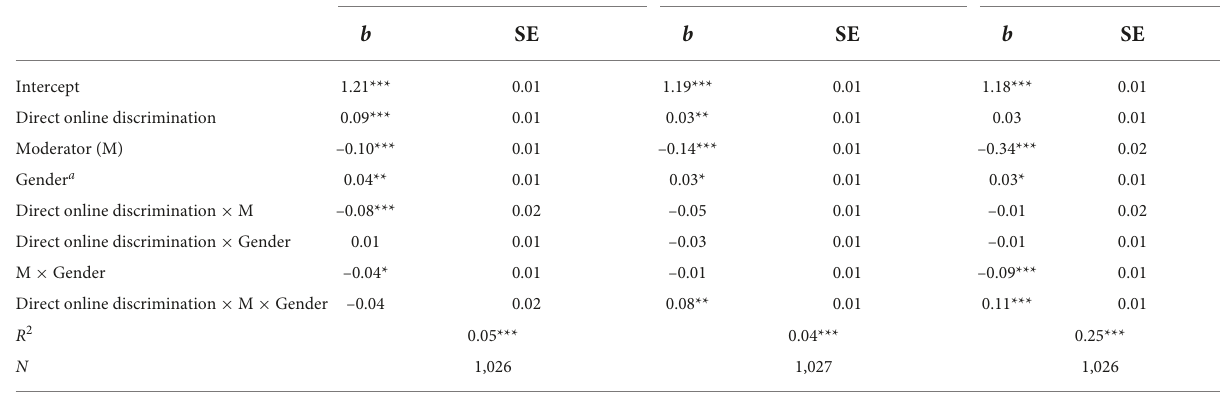
TABLE 2 Regression coefficients for the effects of direct online discrimination by vicarious online discrimination, parental technological attitudes and racial identity centrality on adolescents’ transformed internalized computing stereotypes. Vicarious online discrimination Parental technological attitudes Racial identity